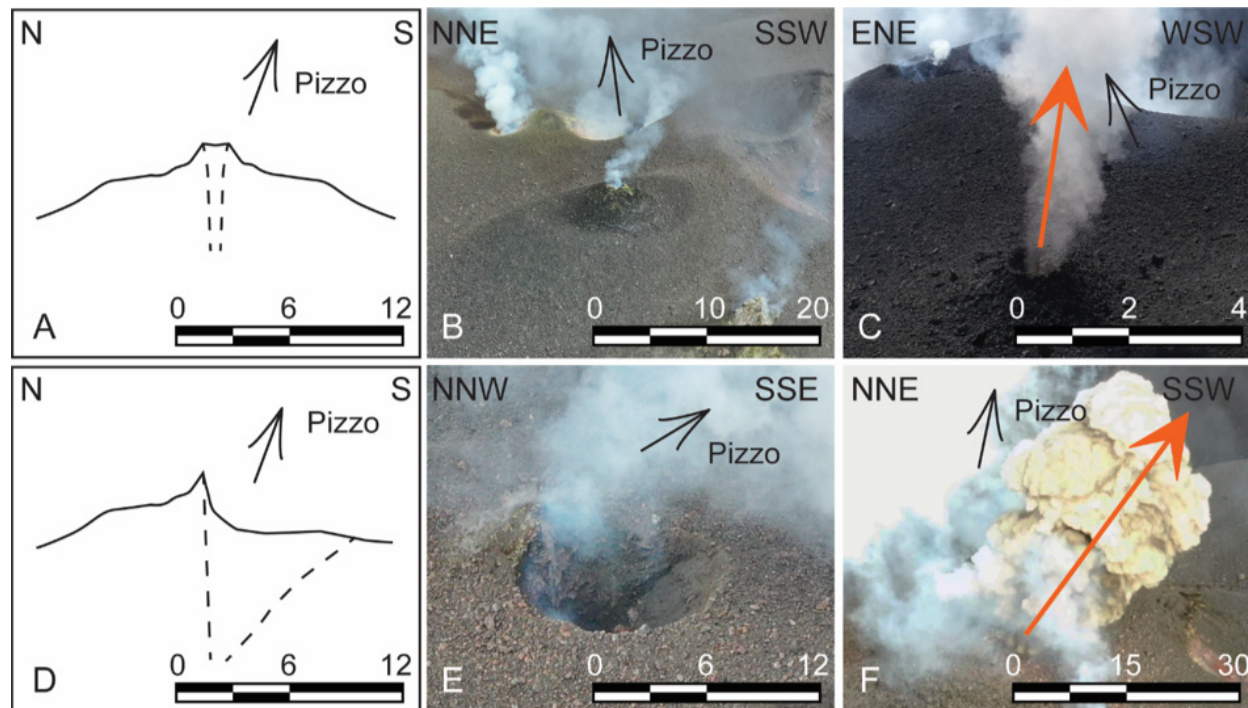
Figure 8: Vent geometry changes of S1 in May 2019 and the resulting modification of the eruption dynamics. [A] shows a sketch of S1’s geometry on 11 May 2019 [B] the corrsesponding image, [C] an associated gas-rich jet. [D] shows a sketch and [E] an image of the same vent’s geometry on 15 May 2019 after the partial destruction. [G] shows an explosion on 15 May 2019 that is directed towards the lower (open) side of the crater rime of S1. Also visible is the changed composition of the jet with a significantly higher content of